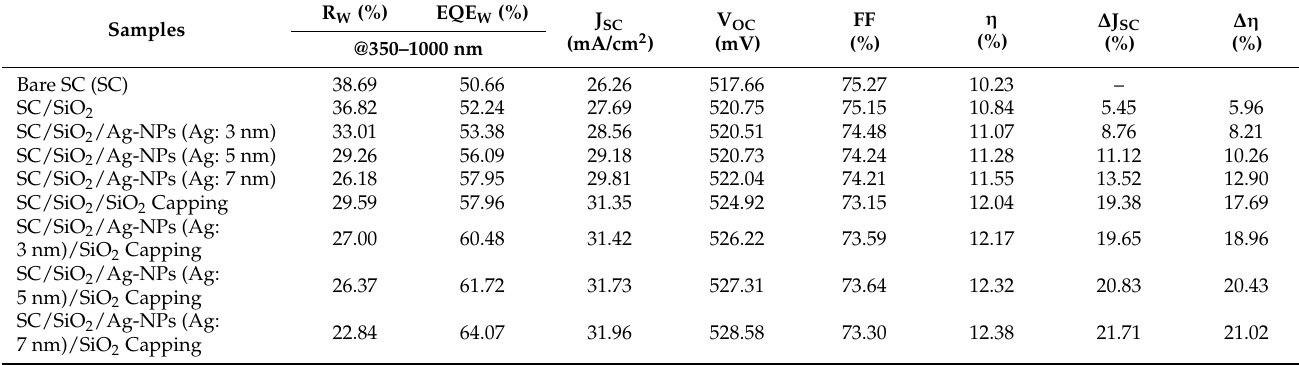
Figure 4. Optical reflectance of all evaluated solar cells. Table 1. Average weighted reflectance ( R W ), average weighted EQE ( EQE W ), and photovoltaic performance of all evaluated solar